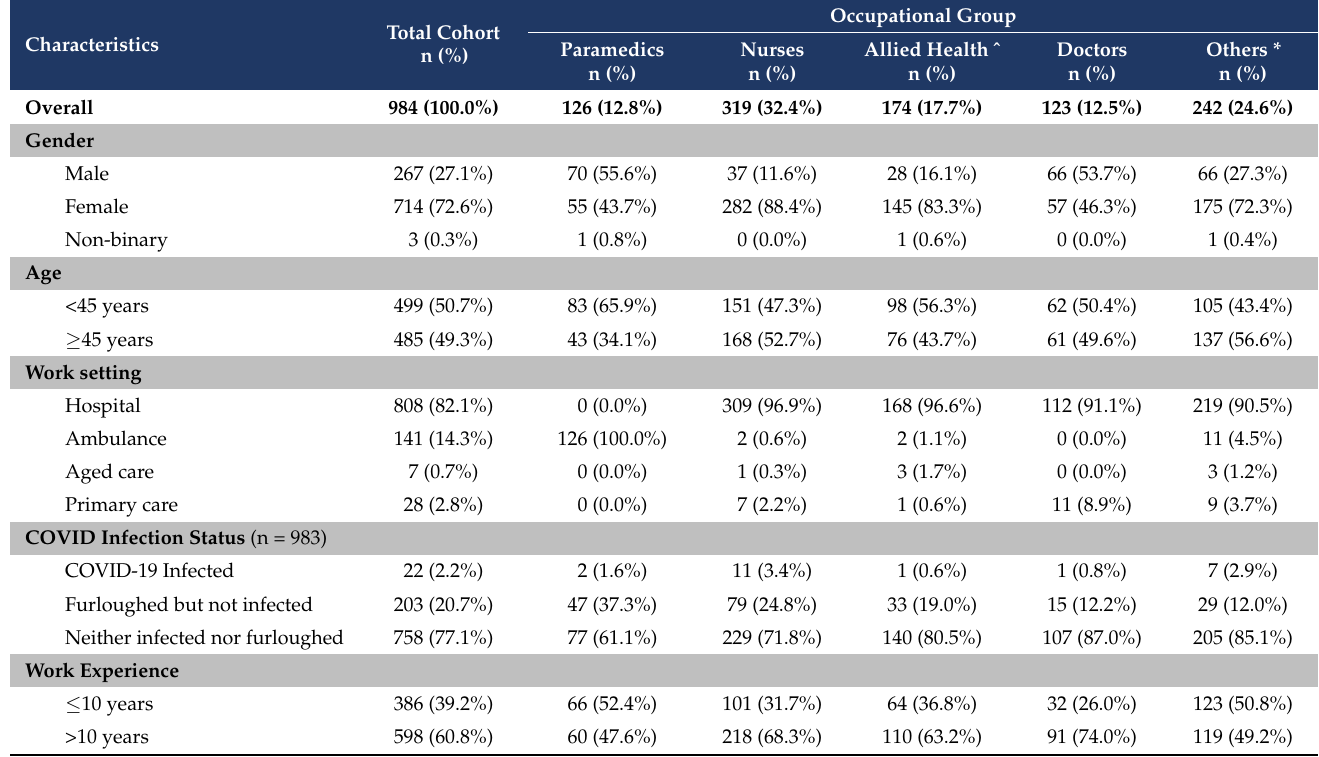
Table 1. Baseline characteristics of COVIC-HA study population by occupational